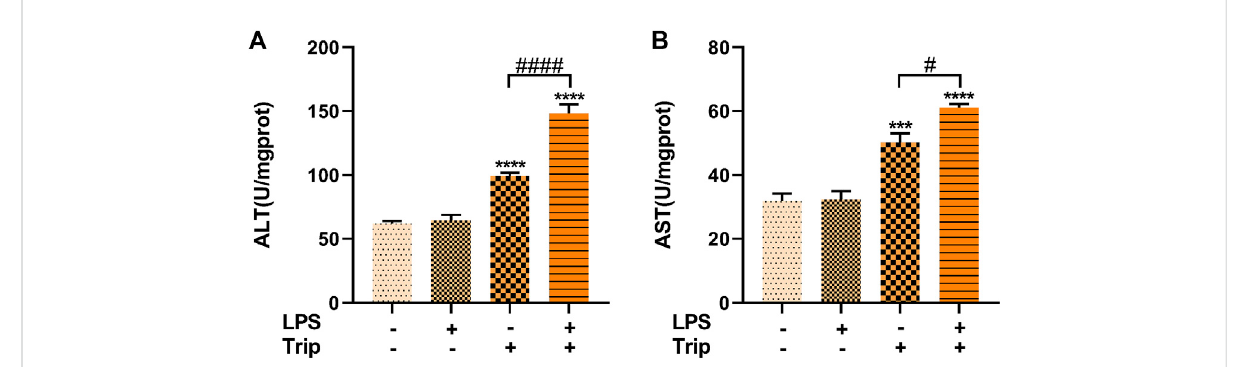
FIGURE 2 Biochemicalanalysisoftheeffectoftriptolide. (A) ALTactivityinzebra fi sh. (B) ASTactivityinzebra fi sh.*** p < 0.001,**** p <